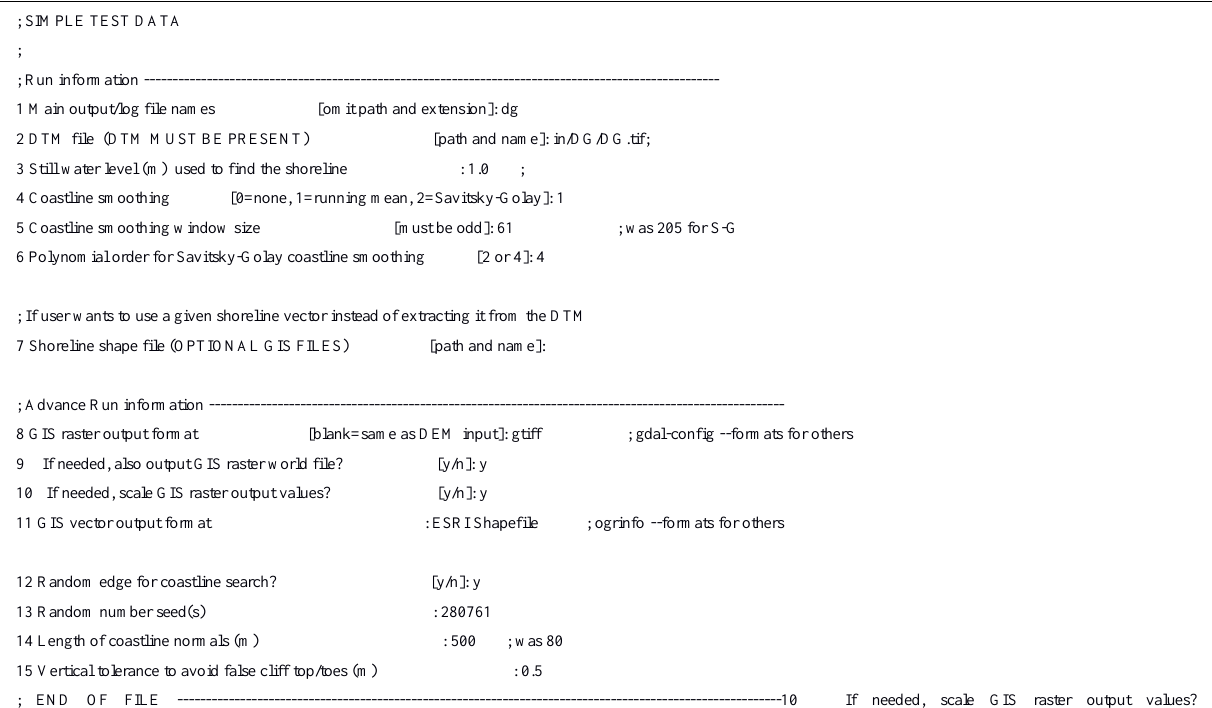
Table 6. ASCII input file with the user-defined delineation